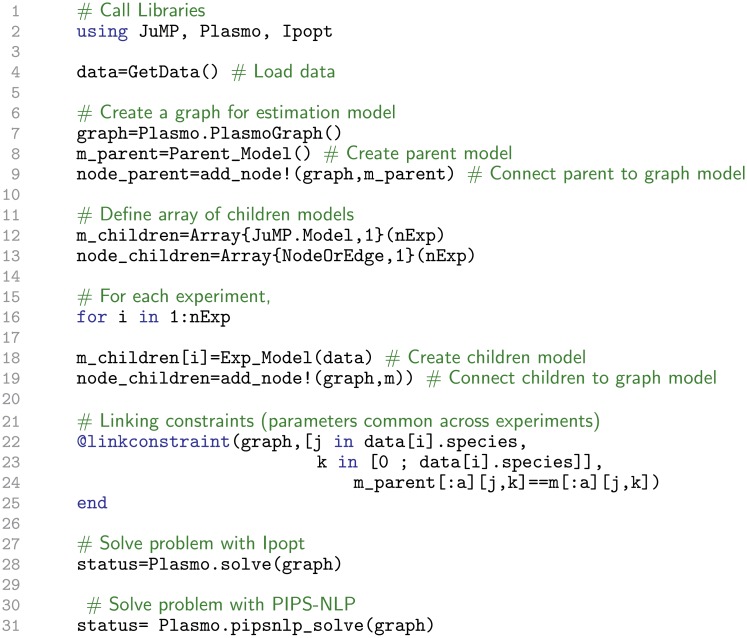
Snippet of parameter estimation implementation in Plasmo.jl.